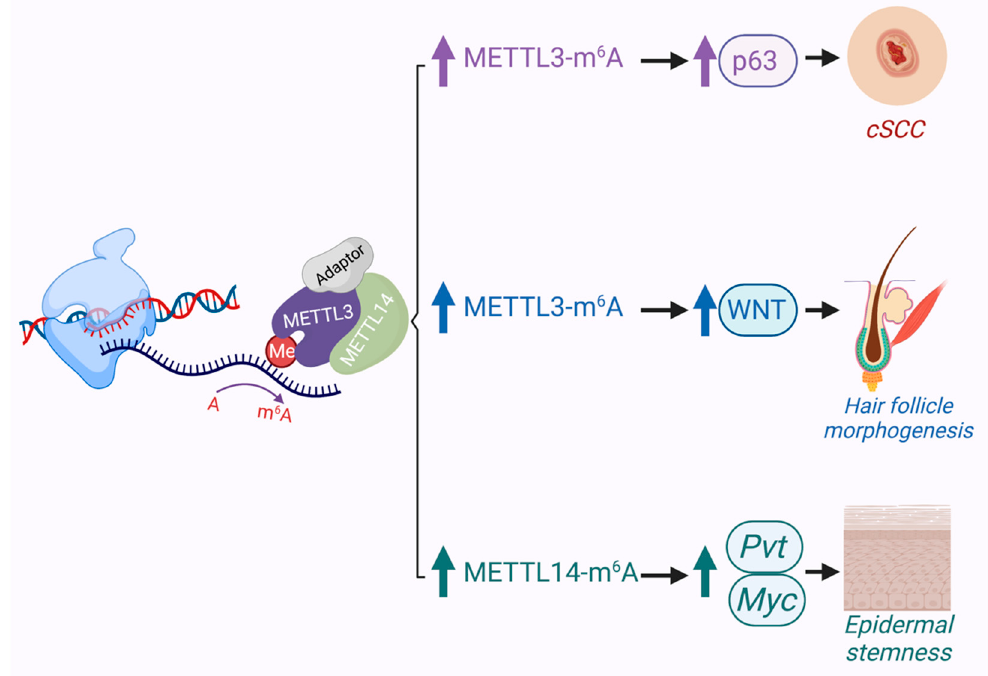
Figure 3. In the skin, evidence suggests that METTL3/14-mediated m6A can play critical roles in development of hair follicles, promoting the epidermal stem cell state, and driving cSCC when over- expressed.